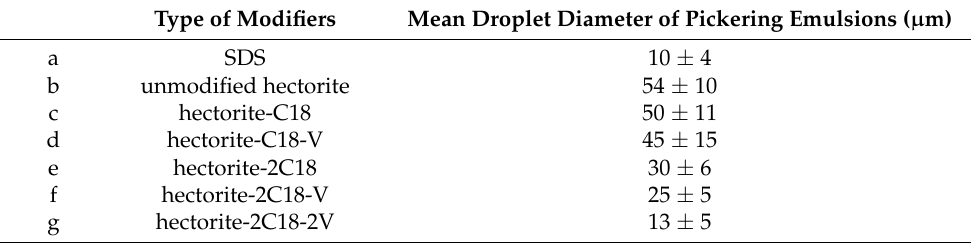
Table 2. Mean droplet diameters of emulsions stabilized by different